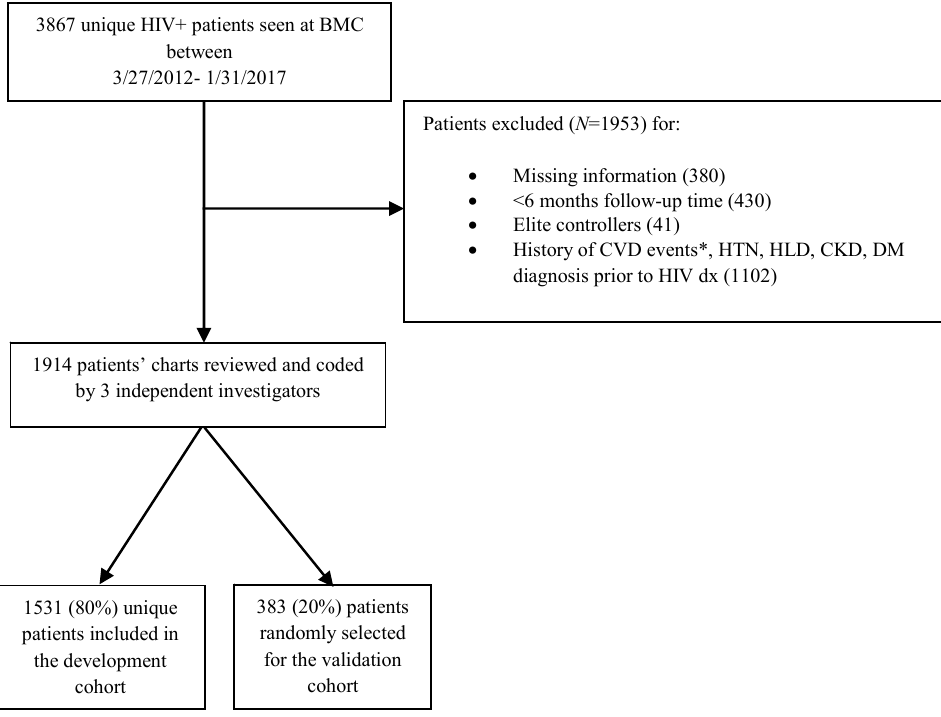
Figure 1. Flow chart showing the selection process used to create development and validation cohorts. BMC: Boston Medical Center; CVD: Cardiovascular disease; HTN: Hypertension; HLD: Hyperlipidemia, CKD: chronic kidney disease; DM: diabetes; HIV: human immunodeficiency virus. * CVD events included sudden cardiac deaths, hospitalizations for unstable angina, myocardial infarctions, strokes, transient ischemic attacks, carotid endarterectomies, and coronary artery bypass graft surgeries.